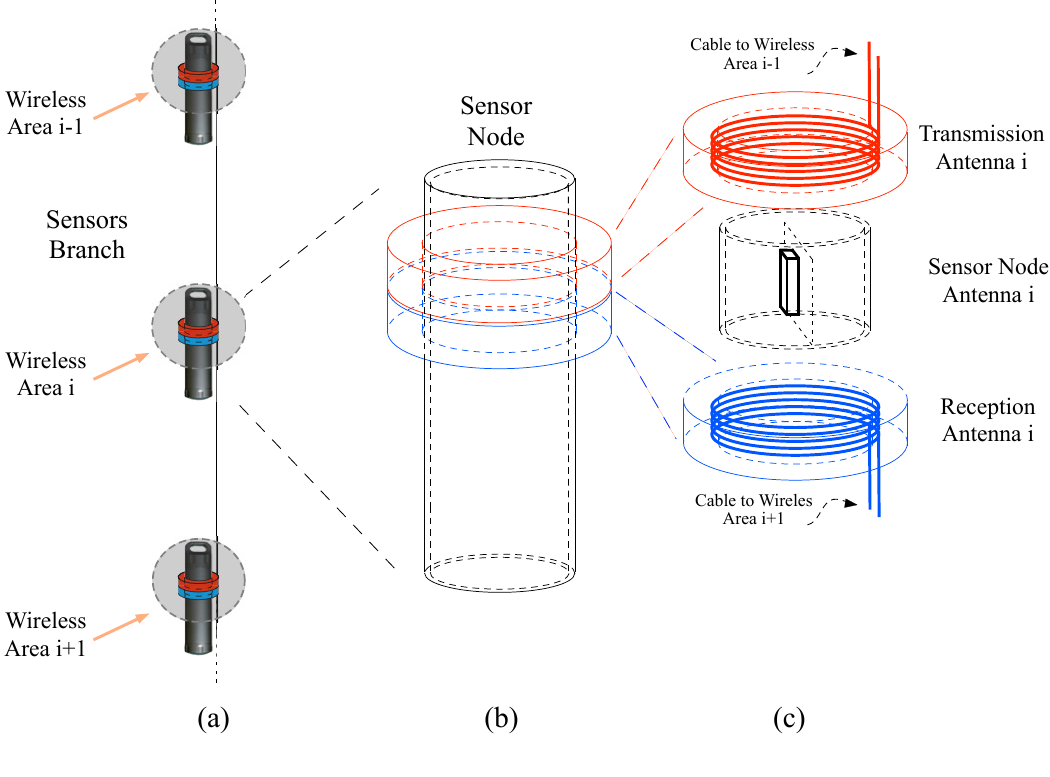
Figure 3. Details of proposed branch for the wireless sensor network; ( a ) wireless areas along network branch, ( b ) sensor node capsule and ( c ) antennas location